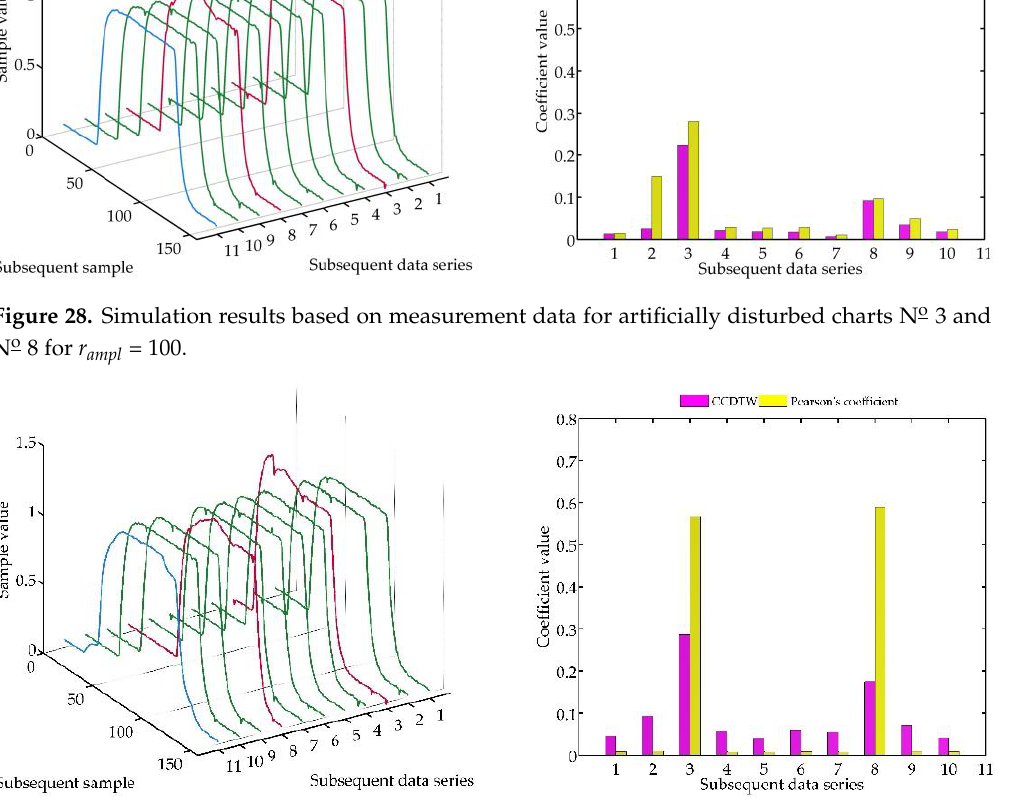
Figure 29. Simulation results based on measurement data for artificially disturbed and shifted charts № 3 and № 8 for r ampl = 2.